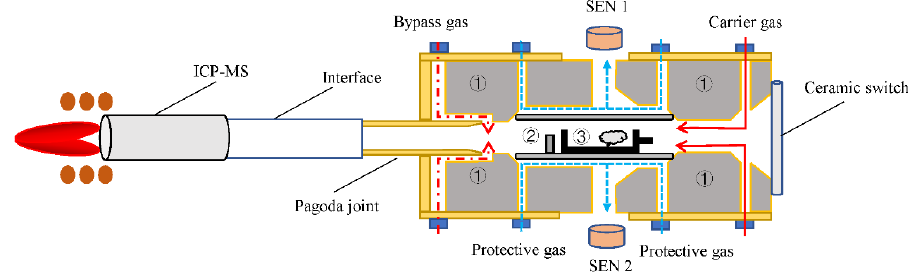
Figure 1. Schematic diagram of DS-ETV-ICP-MS instrumentation. SEN1 and SEN2 refer to the photoelectric sensor and infrared sensor, respectively. ① refers to the graphite electrode embedded in the copper base. ② and ③ refer to the graphite tube and sample boat, respectively. The red solid line refers to the carrier gas path, the blue dotted line refers to the protective gas flow path and the red dotted line refers to the bypass gas flow path, respectively.